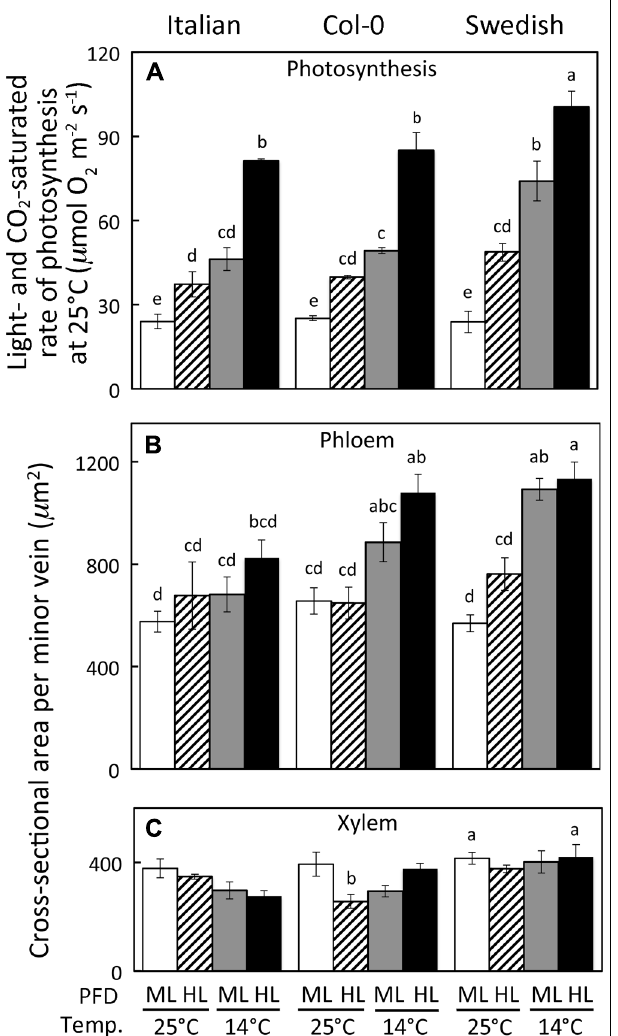
FIGURE 1 | (A) Light- and CO 2 -saturated rate of photosynthetic oxygen evolution, (B) minor loading vein phloem tissue cross-sectional area, and (C) minor vein xylem tissue cross-sectional area of A. thaliana Italian, Swedish, and wild-type Col-0 ecotypes grown under controlled temperature (mean leaf temperature in ◦ C) and PFD (ML = 400 and HL = 1000 μ mol photons m − 2 s − 1 ) conditions. Actual daytime leaf temperatures varied between 24 and 26 ◦ C or between 12 and 16 ◦ C. Mean ± standard deviation shown for light- and CO 2 -saturated rate of photosynthetic oxygen evolution (A) and mean ± standard error of the mean shown for leaf vascular features (B,C) ( n = 4 plants); statistically significant differences indicated with lower case letters ( P < 0.05).